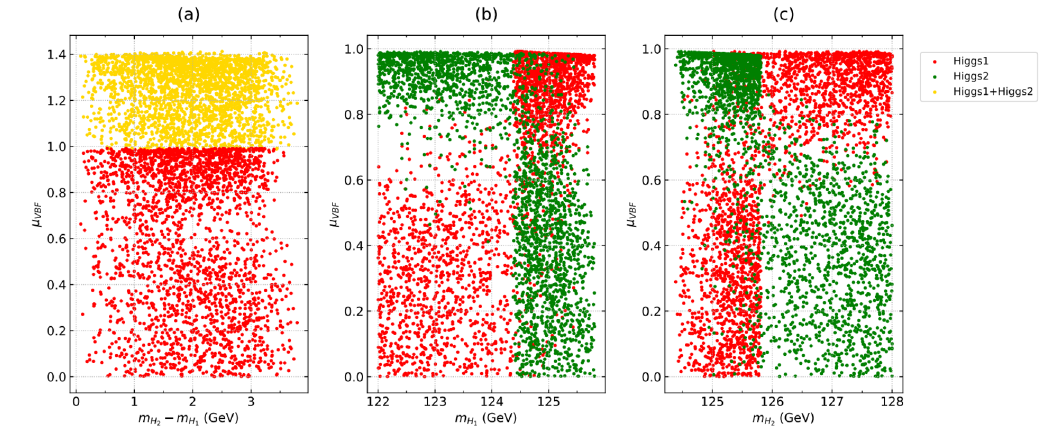
versus µ , − m H V BF 2 1 = σ H 1 , the green /σ SM V BF V BF V BF + µ H 2 . V BF V BF